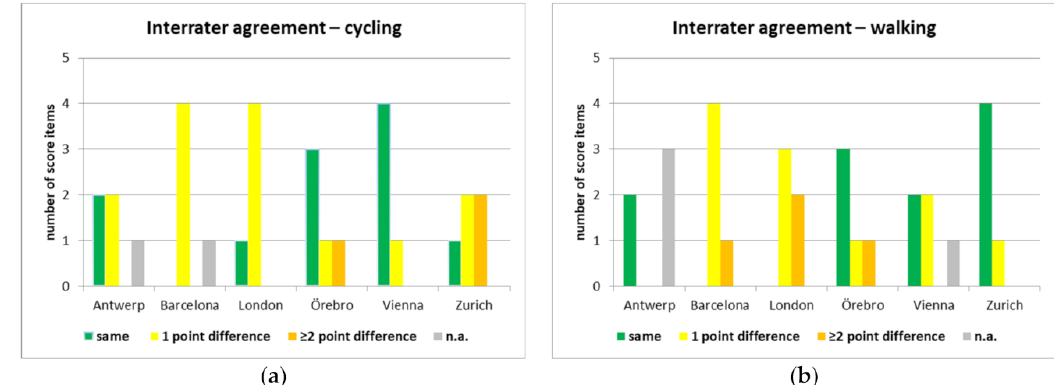
Figure 1. Interrater agreement per case study city, shown as number of five score items that were rated the same by both experts, with a one-point difference, or with a two-point or more difference on the rating scale from zero to four. ( a ) Interrater agreement for the policy friendliness score on cycling; ( b ) Interrater agreement for the policy friendliness score on walking.